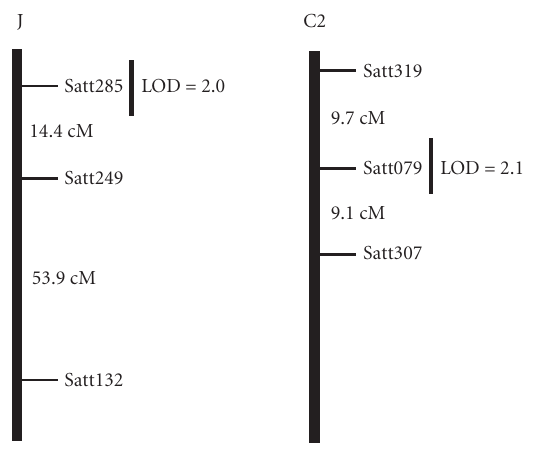
Figure 2. Location of microsatellite markers and three QTLs conditioning trigonelline biosynthesis in soybean grown under conventional field condi- tion. The markers were assigned to the linkage groups C2, J, and L based on the soybean genetic linkage map [39]. END indicates the likely position of the telomere on designated linkage group. Names and distances of mark- ers, and peak LOD score for the interval are given. The QTL LOD scores are from single locus analyses of additive gene e ff ects using Mapmaker/QTL